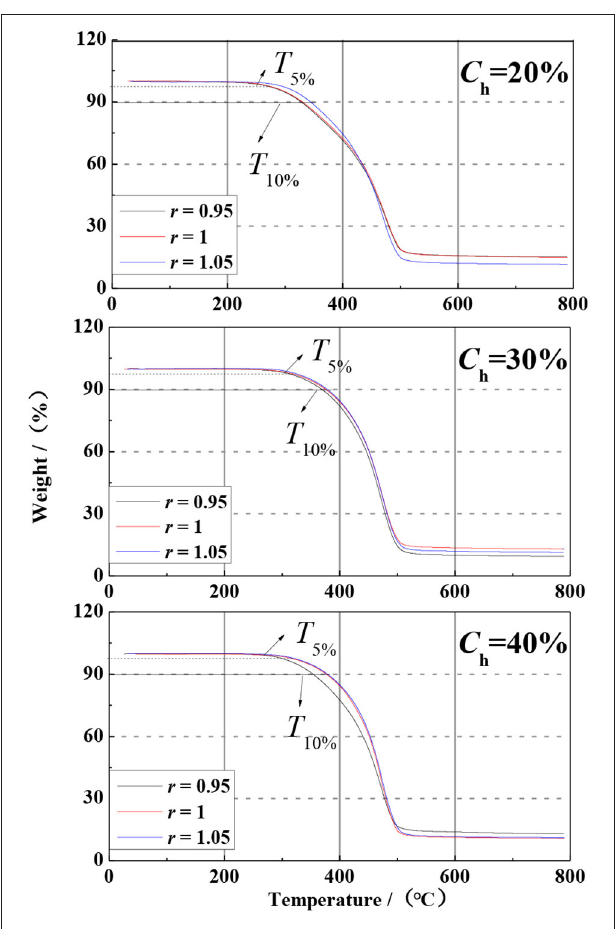
FIGURE 24 | TG curves of polyester-based TPU-modified asphalt.